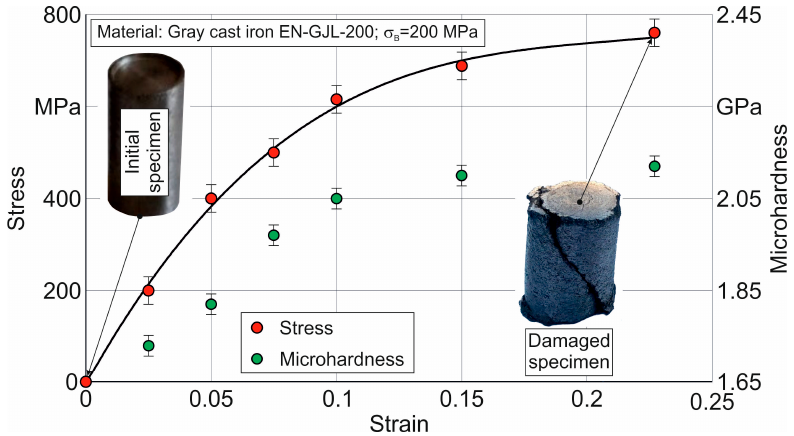
Figure 2. Flow curve of gray cast iron EN-GJL-200 with initial and damaged